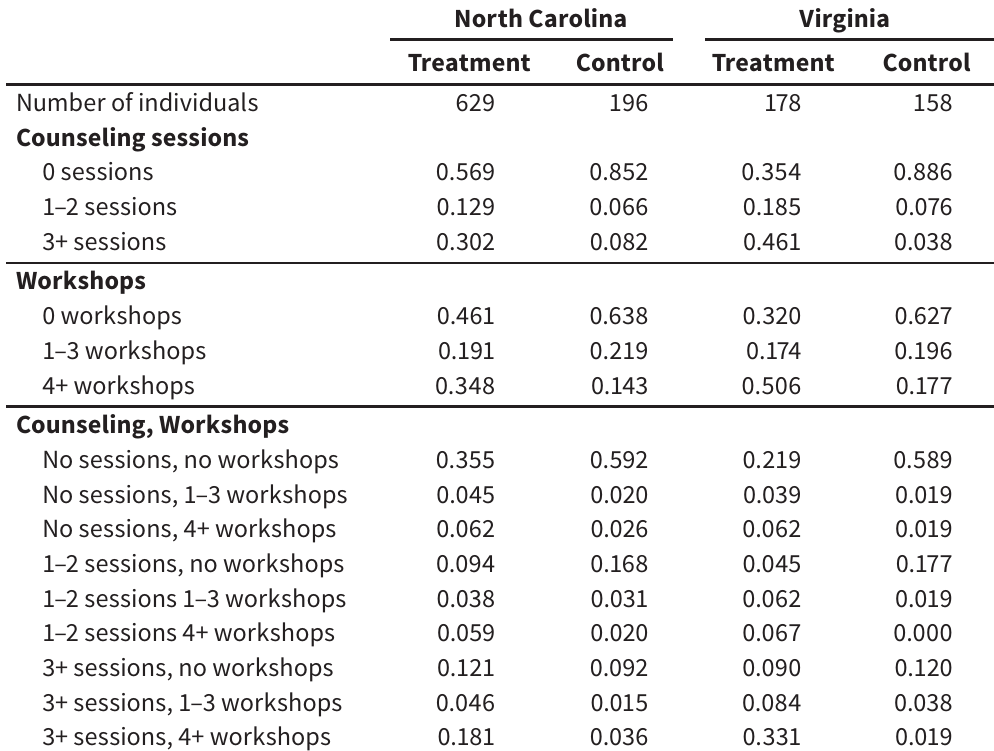
Distribution of counseling sessions and workshops, GATE